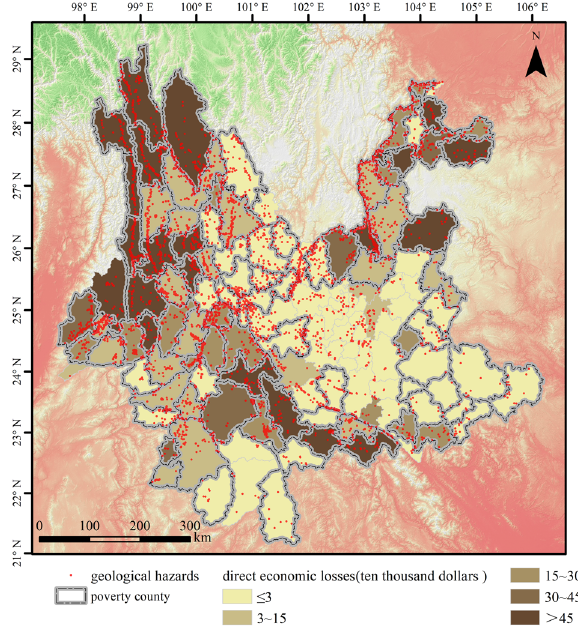
Fig. 2 Distribution of geological hazards, and related direct economic losses (average values in 2009 – 2017) in Yunnan Province. There were 88 poverty-stricken counties in Yunnan Province in 2015 Annual per capita income of RMB 4000.00 is regarded as the poverty household. A county with a percentage of poor households >3% is considered a poor county. Most of these poor counties are in areas with frequent geological